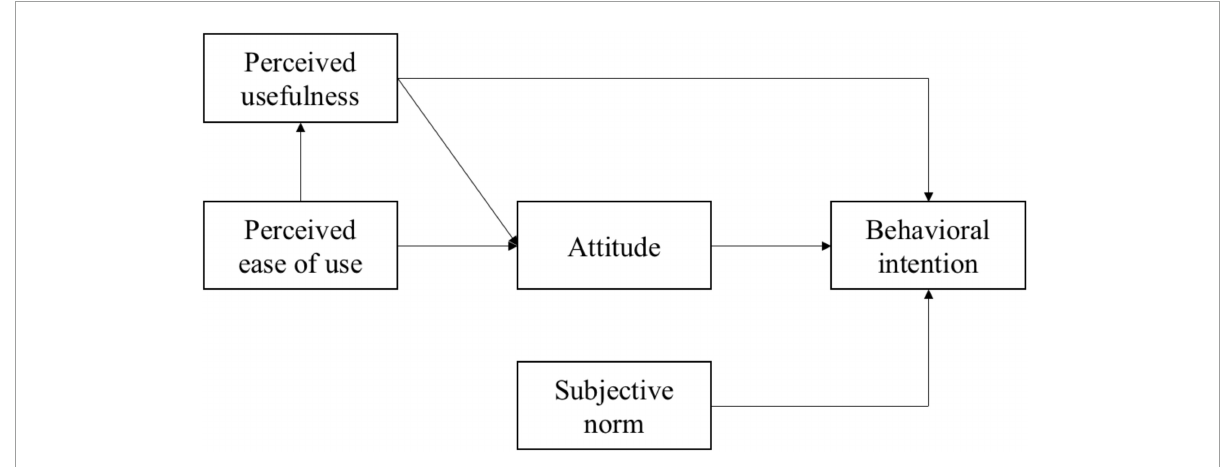
FIGURE1 Conceptual framework based on an extended technology acceptance